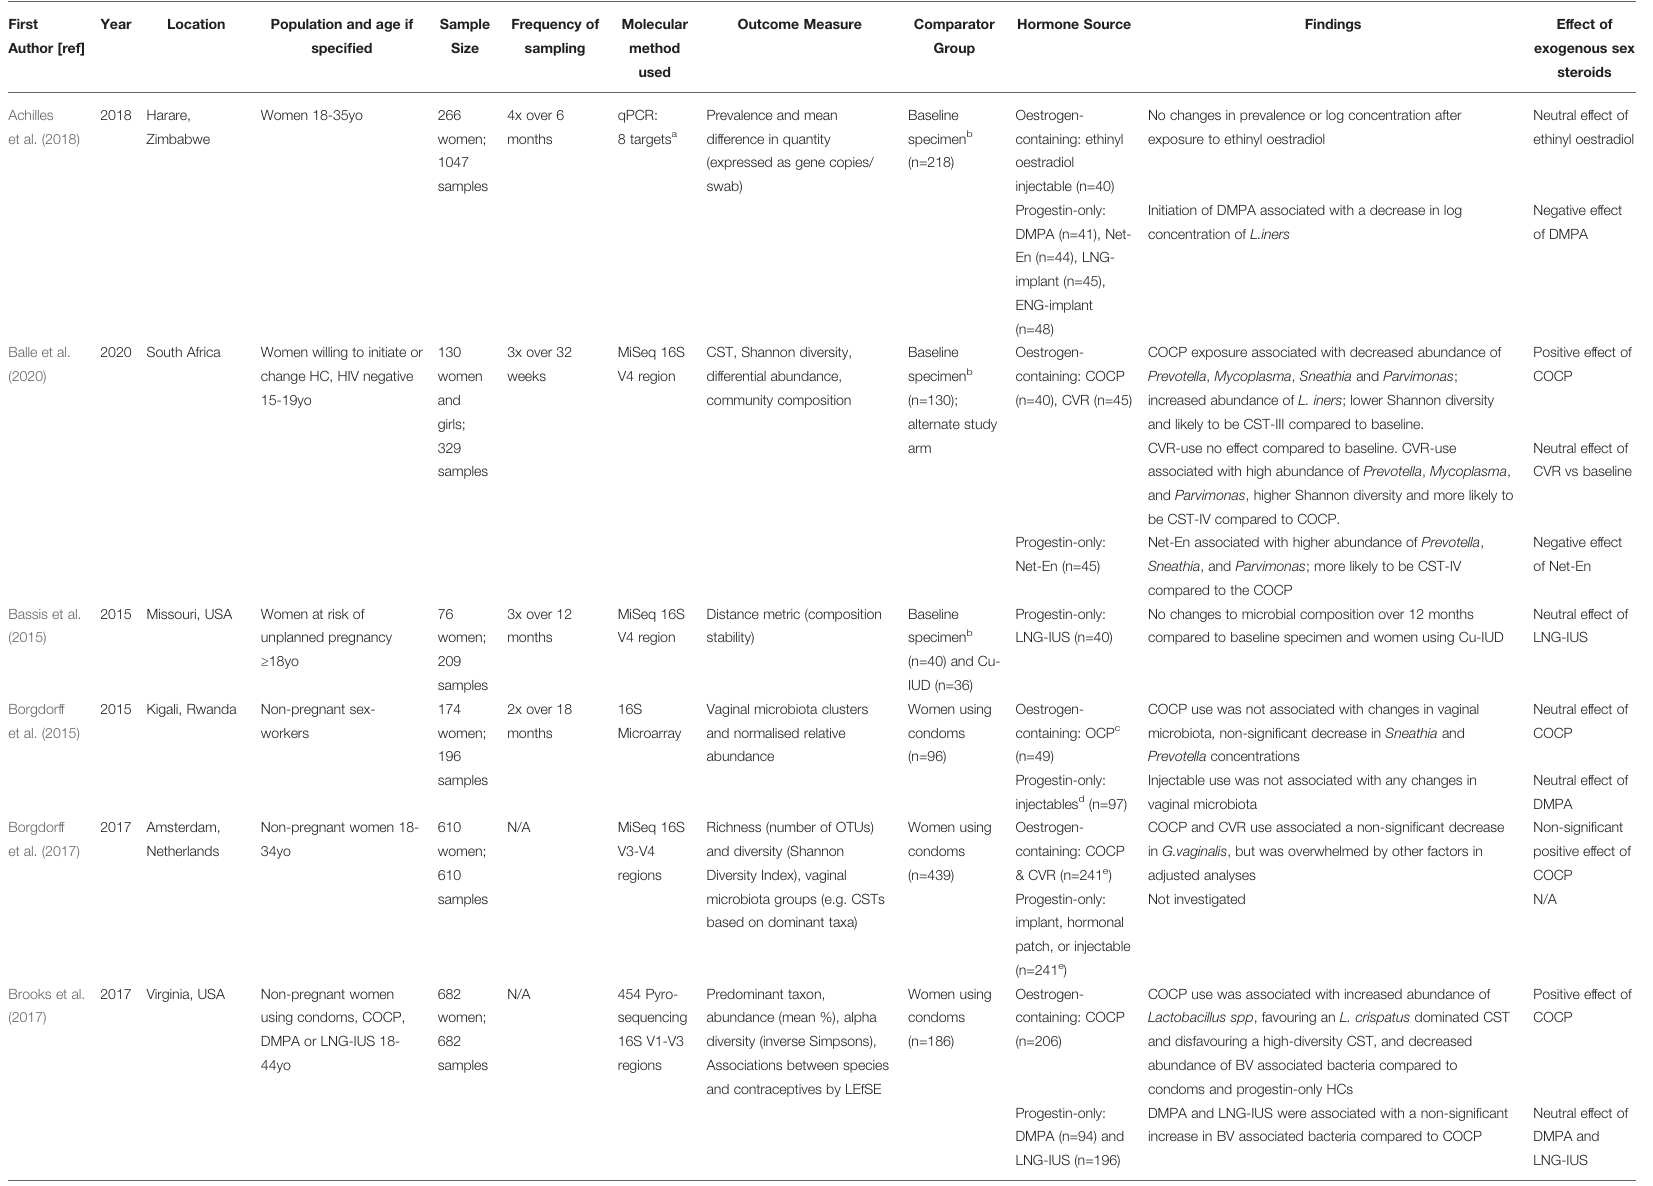
TABLE 1 | Result summary of hormonal contraceptive